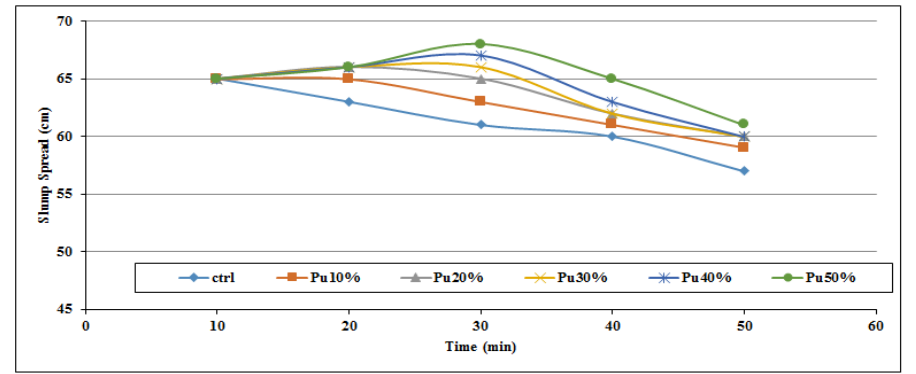
Figure 3. Slump loss diagram for pumice powder samples throughout the first 50 min.